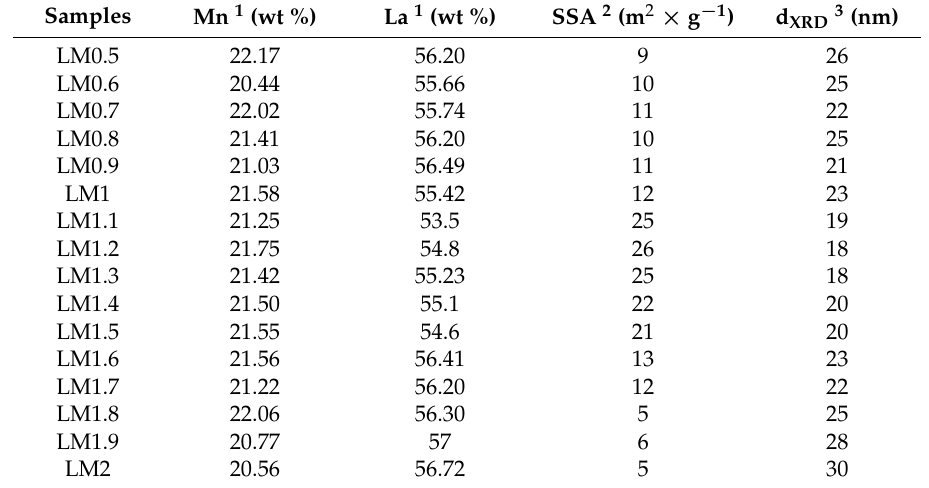
Table 1. Chemical composition and textural properties of LaMnO 3 catalysts as a function of citric acid (CA) to metal ions (La 3+ + Mn 3+ ) molar